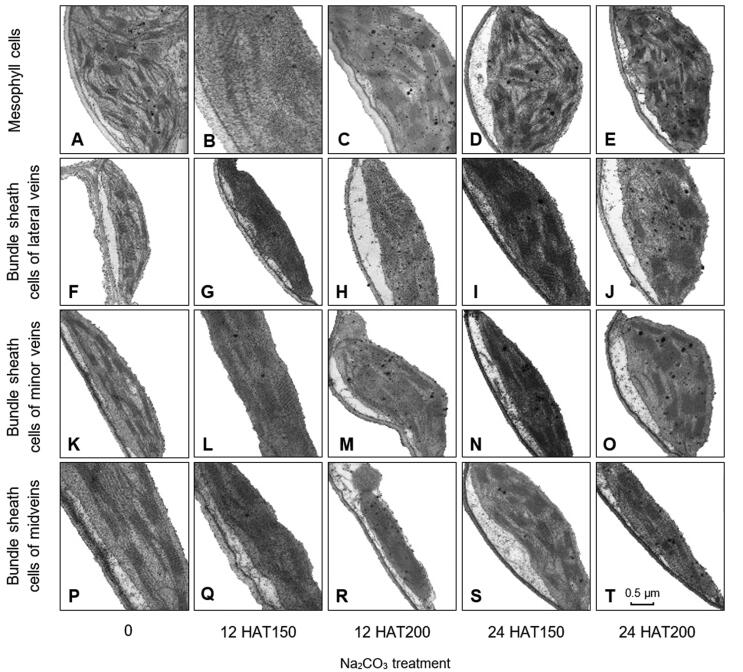
Ultrastructure of chloroplasts in alkaligrass leaves under Na2CO3 treatmentA.–E. Chloroplasts in mesophyll cells after plants were treated with Na2CO3 at 0 mM (A), 150 mM for 12 h (12 HAT150) (B), 200 mM for12 h (12 HAT200) (C), 150 mM for 24 h (24 HAT150) (D), or 200 mM for 24 h (24 HAT200) (E). F.–J. Chloroplasts in bundle sheath cells of lateral veins were treated with Na2CO3 at 0 mM (F), 12 HAT150 (G), 12 HAT200 (H), 24 HAT150 (I), or 24 HAT200 (J). K.–O. Chloroplasts in bundle sheath cells of minor veins were treated with Na2CO3 at 0 mM (K), 12 HAT150 (L), 12 HAT200 (M), 24 HAT150 (N), or 24 HAT200 (O). P.–T. Chloroplasts in bundle sheath cells of midveins were treated with Na2CO3 at 0 mM (P), 12 HAT150 (Q), 12 HAT200 (R), 24 HAT150 (S), or 24 HAT200 (T). Bar = 0.5 μm.